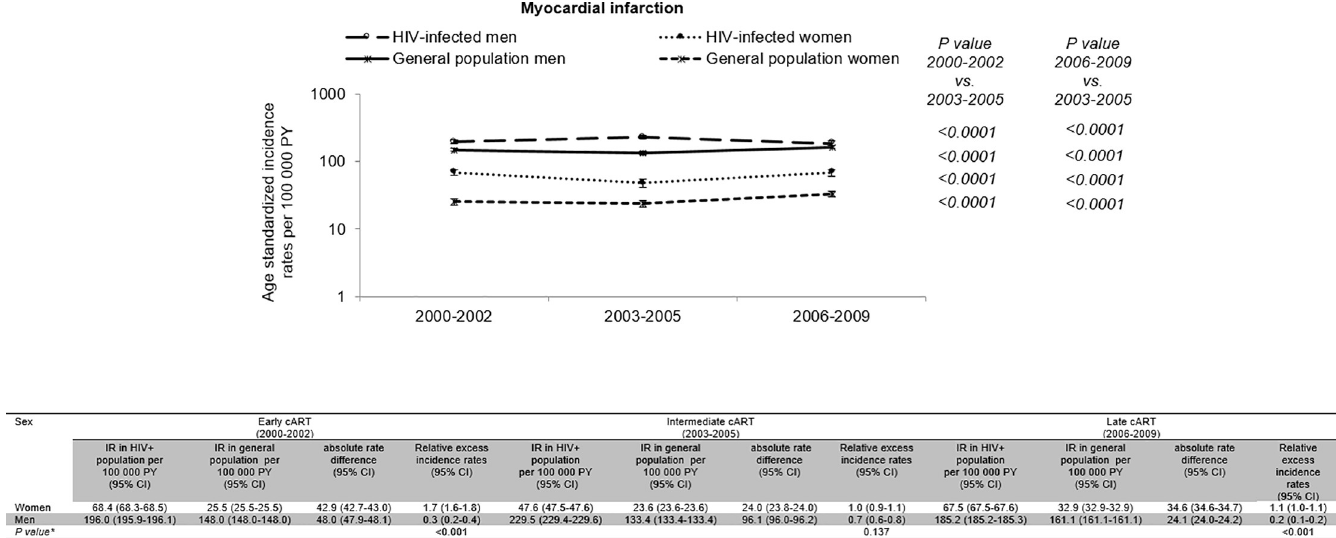
Fig 1. Myocardial infarction standardized incidence rates, absolute rate difference and corresponding 95% confidence intervals in the HIV-infected and general populations in calendar period. Standardization is based on the age and gender distribution of the HIV-infected population between 2000 and 2009. Abbreviations : cART, combination antiretroviral therapy; HIV, human immunodeficiency virus; CI, confidence interval; PY, person-years; IR, incidence rate. The absolute rate difference (shown with the 95% confidence interval) per 100 000 person-years was estimated as the difference in the age standardized incidence rate between HIV– infected individuals and the general population. For each gender, the relative excess incidence rate in each calendar period was obtained dividing the absolute rate difference by the incidence rate in the general population. � P values for the relative excess incidence rates were obtained by Poisson regression by comparison between men and women in each calendar